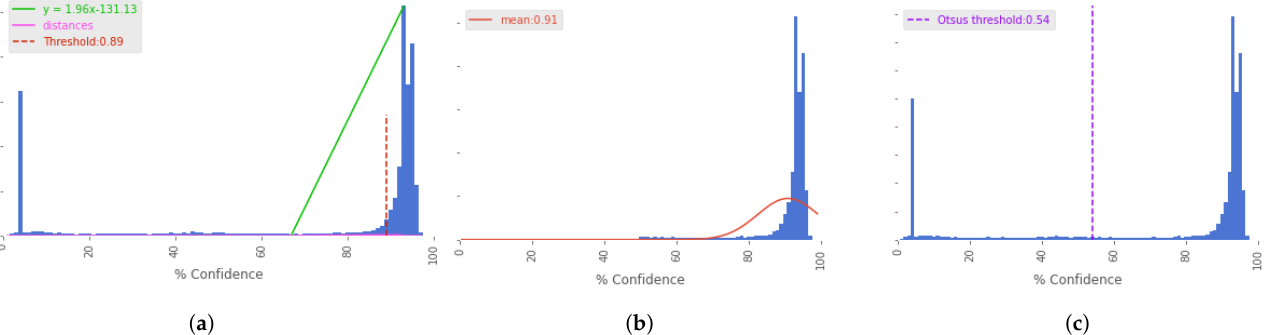
Figure 2. Confidence histogram of a Slakh2100 example track and its Minimum confidence estimation (see Section 2.1.1) according to our three approaches: ( a ) Triangulation, ( b ) Gaussian, ( c ) Otsu.